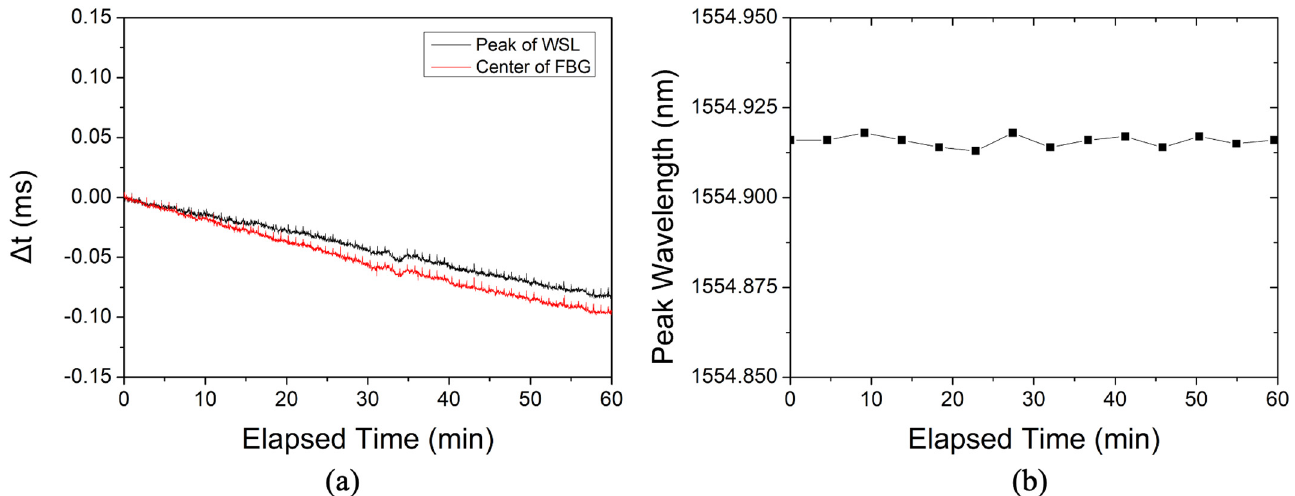
Figure 5. When the WSL stabilization loop is not applied, ( a ) variations of peak position in the temporal domain (black line: peak position of the WSL, red line: reflected signal from the FBG); and ( b ) variation of the peak wavelength reflected from the FBG in the spectral domain.